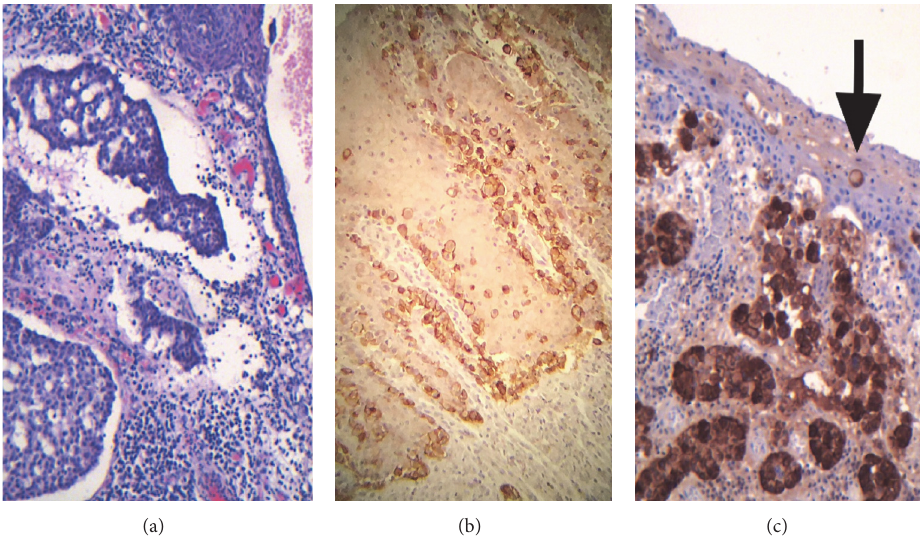
Figure1: (a)Cribriformpattern ofapocrine adenocarcinoma. Original magnification: × 100,hematoxylin/eosin stain. (b)Pagetoid infiltration of the epidermis by the malignant cells which show score 3+ staining for HER 2 in the lateral margin of the resection. Magnification: × 250. (c) Immunostaining for Gross Cystic Disease Fluid Protein-15 (GCDFP-15). Intense and moderate cytoplasmic staining of tumor cells. Pagetoid infiltration of the epidermis by one tumor cell (arrow). Original magnification: ×